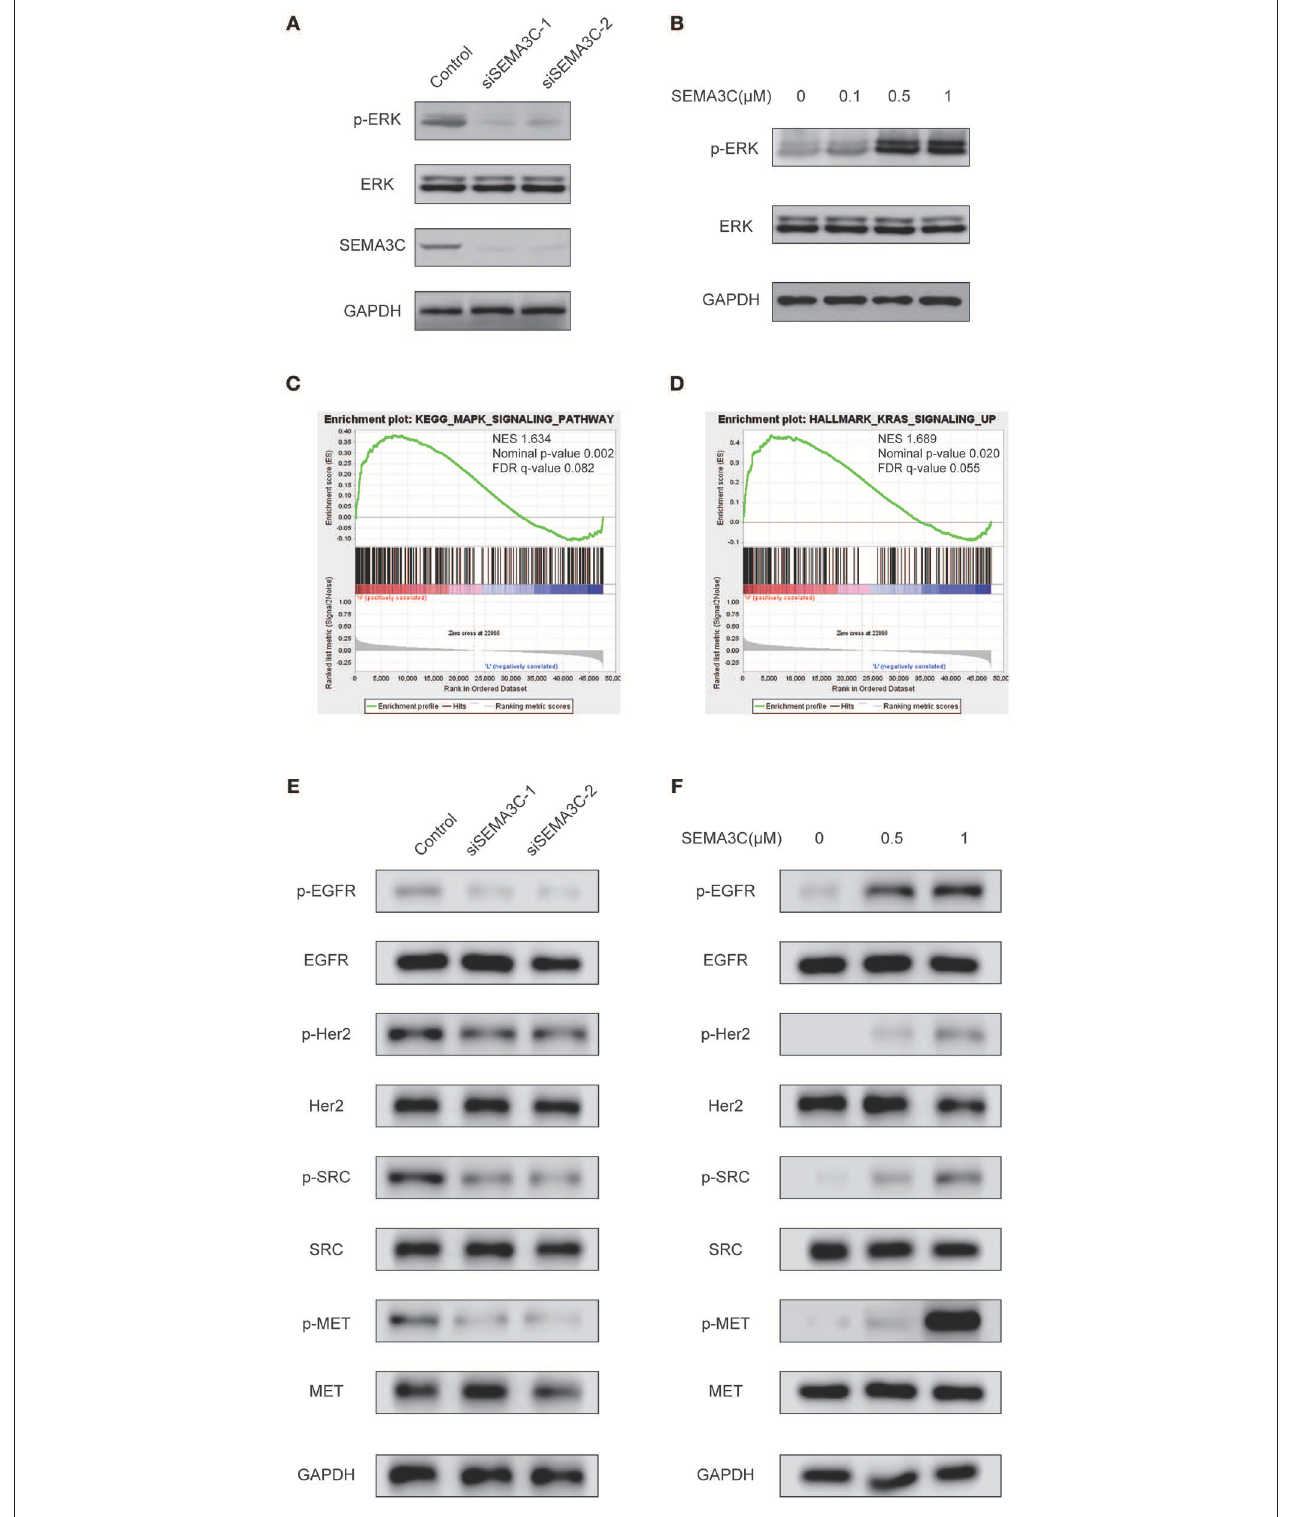
FIGURE 3 | SEMA3C activates the MAPK signaling pathway in cervical cancer cells. (A) SiHa cells transfected with siSEMA3C and control cells were subjected to western blotting assay. (B) Activation of ERK (p44/42) in SiHa cells treated with varying concentrations of recombinant SEMA3C protein for 10min. (C,D) GSEA